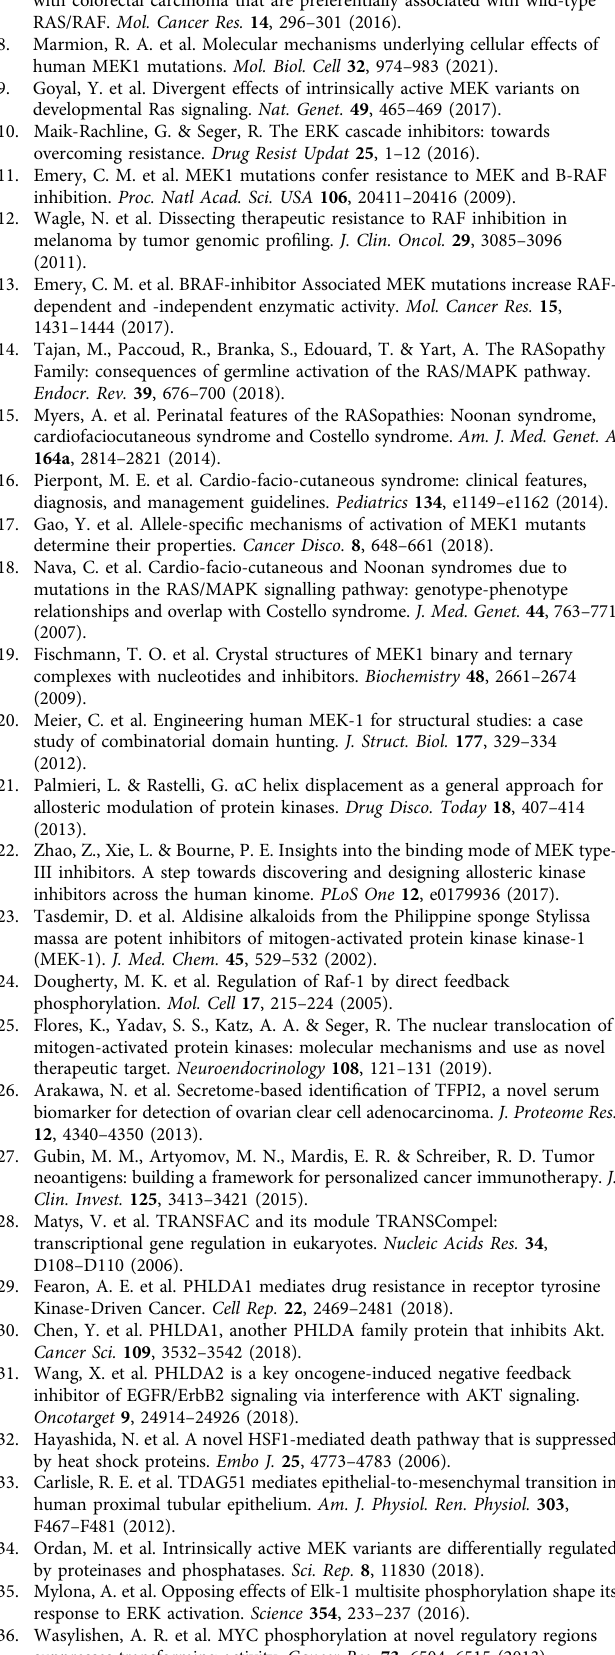
Supplementary Table 2. Primer design and speci fi city check were performed using primer-BLAST (https://www.ncbi.nlm.nih.gov/tools/primer-blast/). To establish the models of gene-expression patterns regulated by ERK signaling, we calculated gene expression levels in the cells with MEK1(F53S or K57N) as fold change (FC) in relation to those in MEK1(WT), and evaluated these FC values based on the following criteria: Linear increase; 1< FC< 2.5, sigmoidal increase; FC ≥ 2.5, and decrease; FC